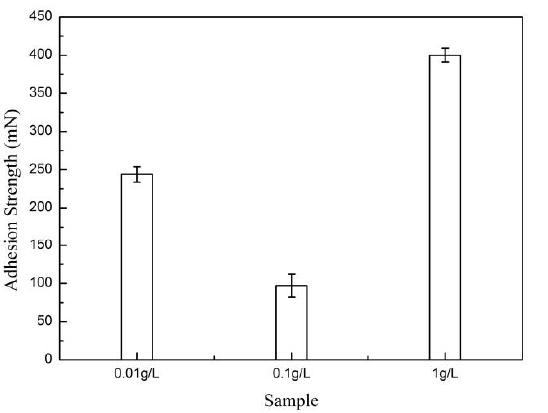
Figure 8. The cross section of SiC-hydroxyapatite coatings with 200 nm SiC particles.